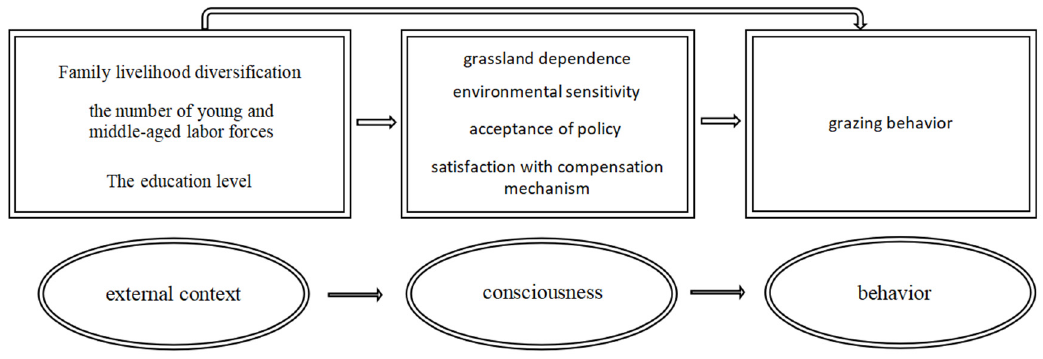
Figure 2. The mechanism model of farmer household characteristics on the consciousness-behavior relationship.